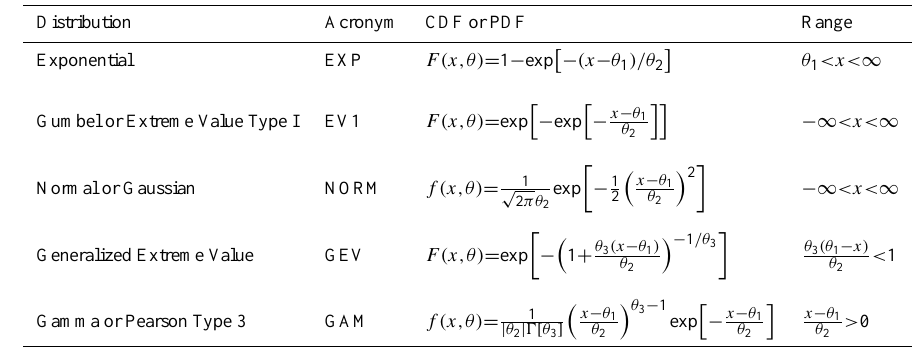
Table 1. Probability models considered in this paper. 0 [·] is the gamma